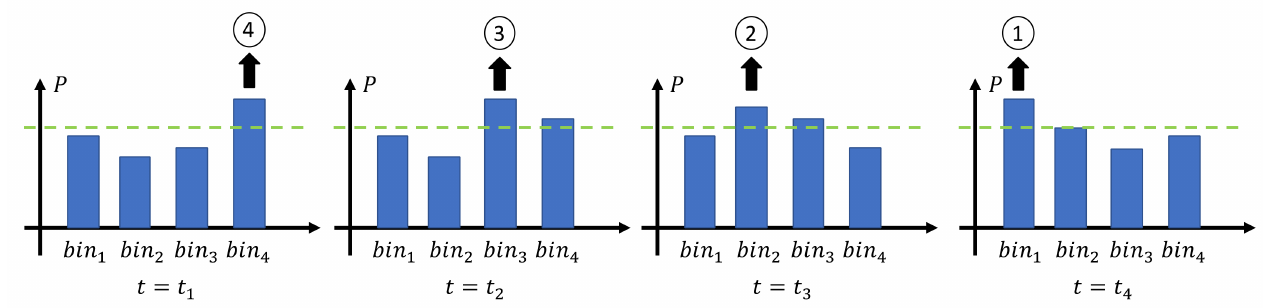
Figure 6. Examples of the bin’s time series when a subject is moving from the right to the left under the infrared